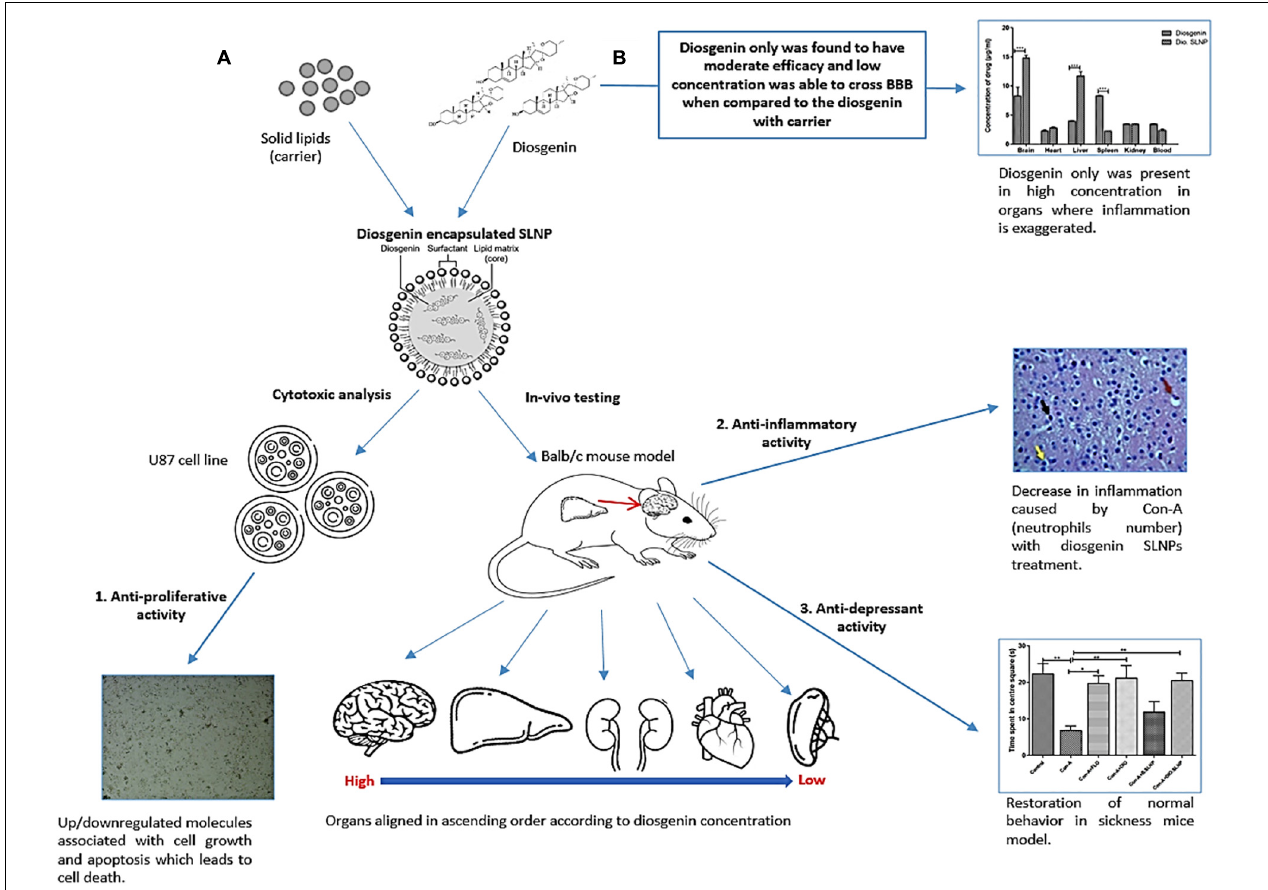
FIGURE 10 | Proposed mechanism of diosgenin encapsulated SLNPs and diosgenin only activity on Con-A–induced sickness in animal model and in vitro analysis. (A) Con-A induces sickness in animal model due to its ability of triggering immune system, which results in the production of inflammatory cytokines. Diosgenin when in carrier decreases the inflammation and its capability of crossing the BBB boosts up while being least toxic. This formulation also restored the normal behavior in sickness mice model and showed anti-proliferative activity in cell line by the regulation of apoptotic molecules. (B) Diosgenin only still shows its therapeutic capability, but being steroid in nature, it is not soluble and its capability to cross the BBB is low. It gets highly concentrated in spleen and liver, which is the site of inflammatory